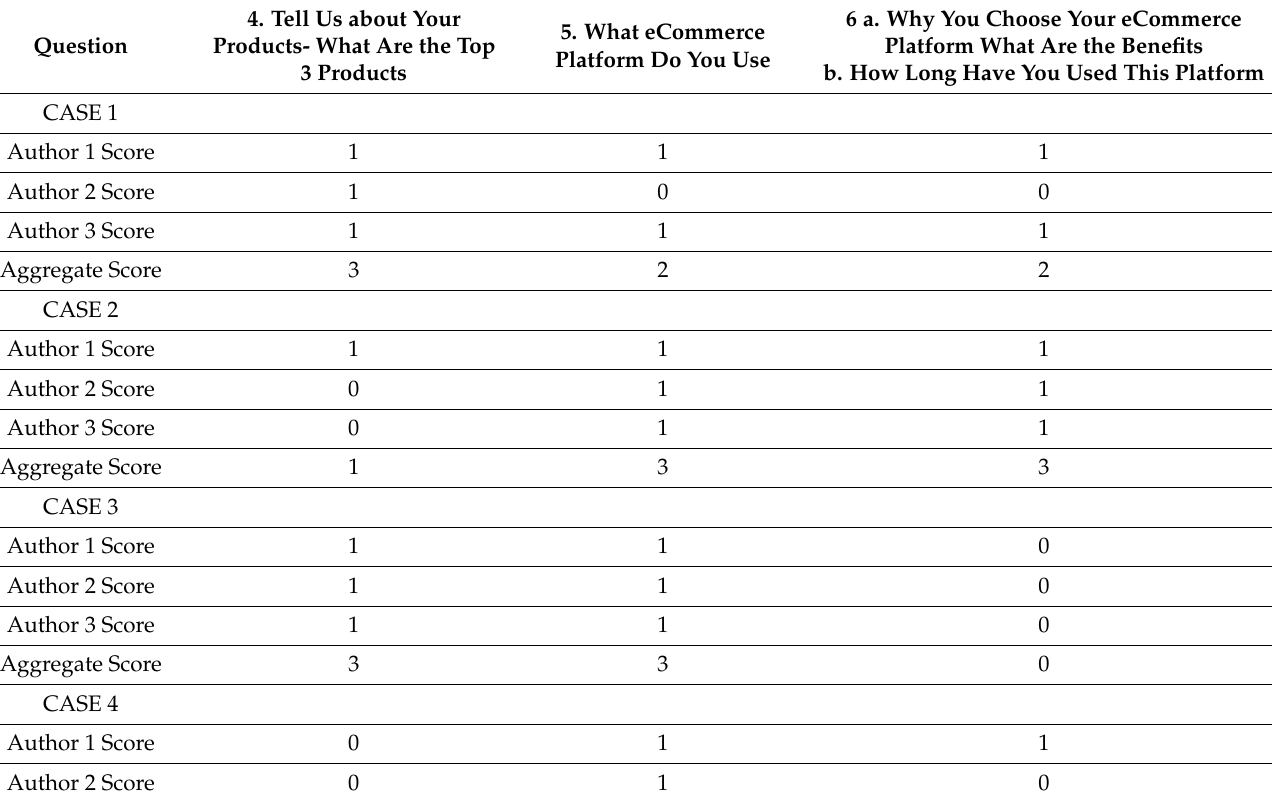
Table A4. Scoring Table for questions